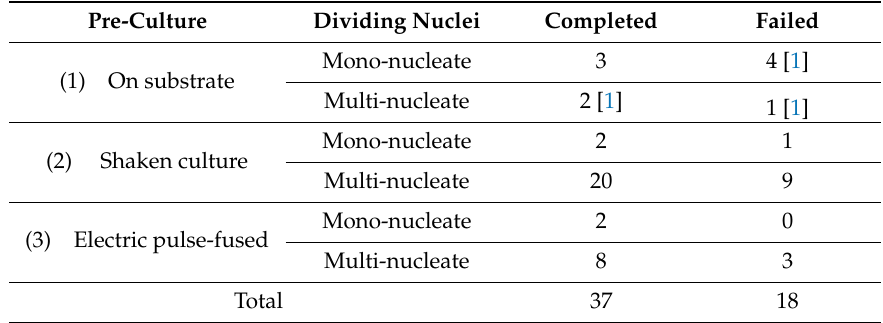
Table 2. Mitosisinmyosin-II-nullcellsattachedtoaglasssurfacewithsuccessfulorunsuccessfulcytokinesis.